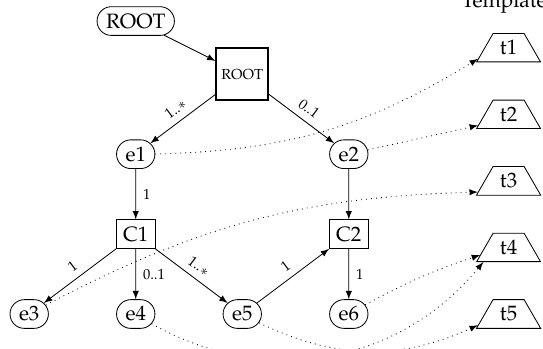
Figure 2. Schema Context graph example. Rounded nodes denote Element s, square nodes eContext s (short form of “Element Context”) and trapezium nodes templates. The numbers in the arrows indicate the cardinality: “1” one child, “1..*” one to many children, “0..1” none or one child